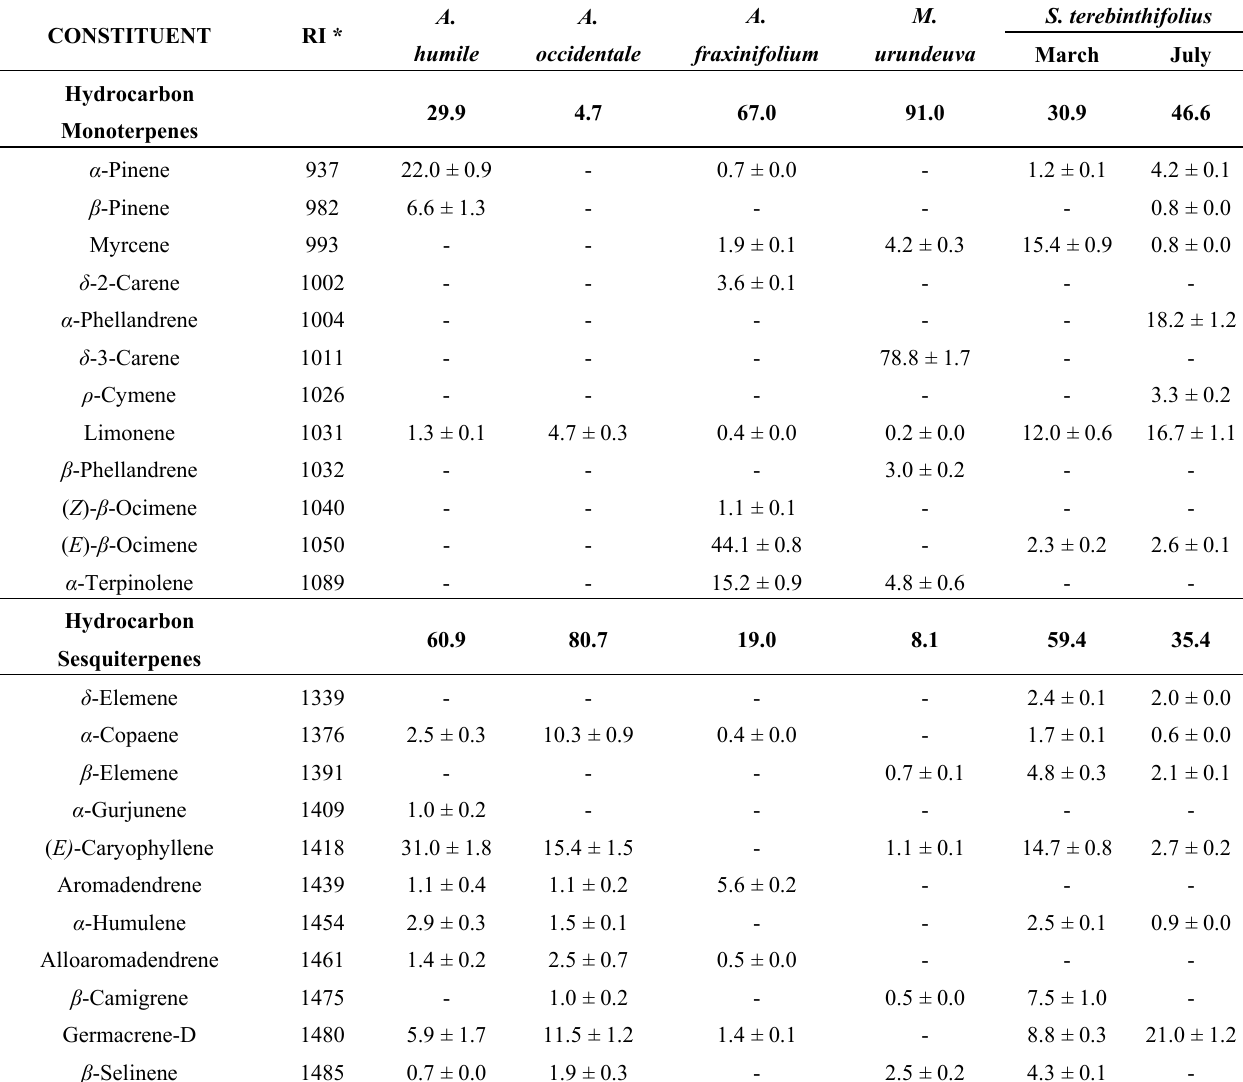
Table 1. Constituents and yields of essential oils (%) from species A. humile , A. occidentale , A. fraxinifolium , M. urundeuva and S.